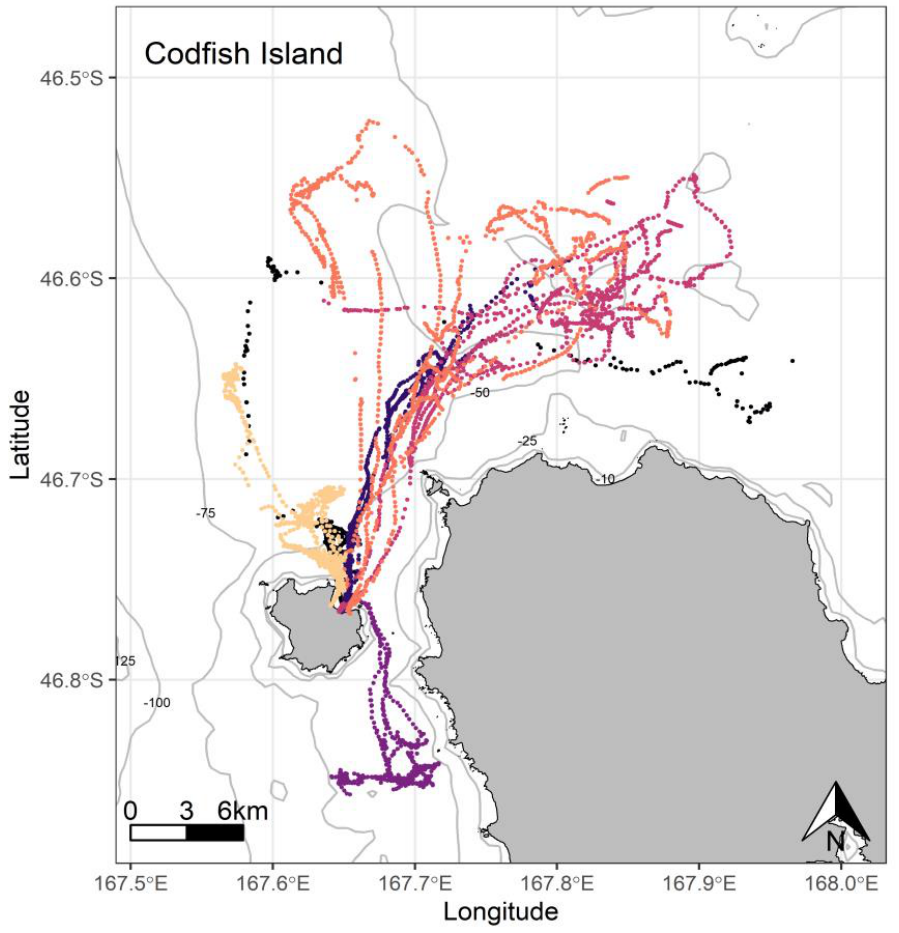
Figure 6. At-sea location fixes (travelling and foraging) of adult breeding yellow-eyed penguins during the chick-guard stage of breeding from Codfish Island, Stewart Island ( n = 6), 2020/21.